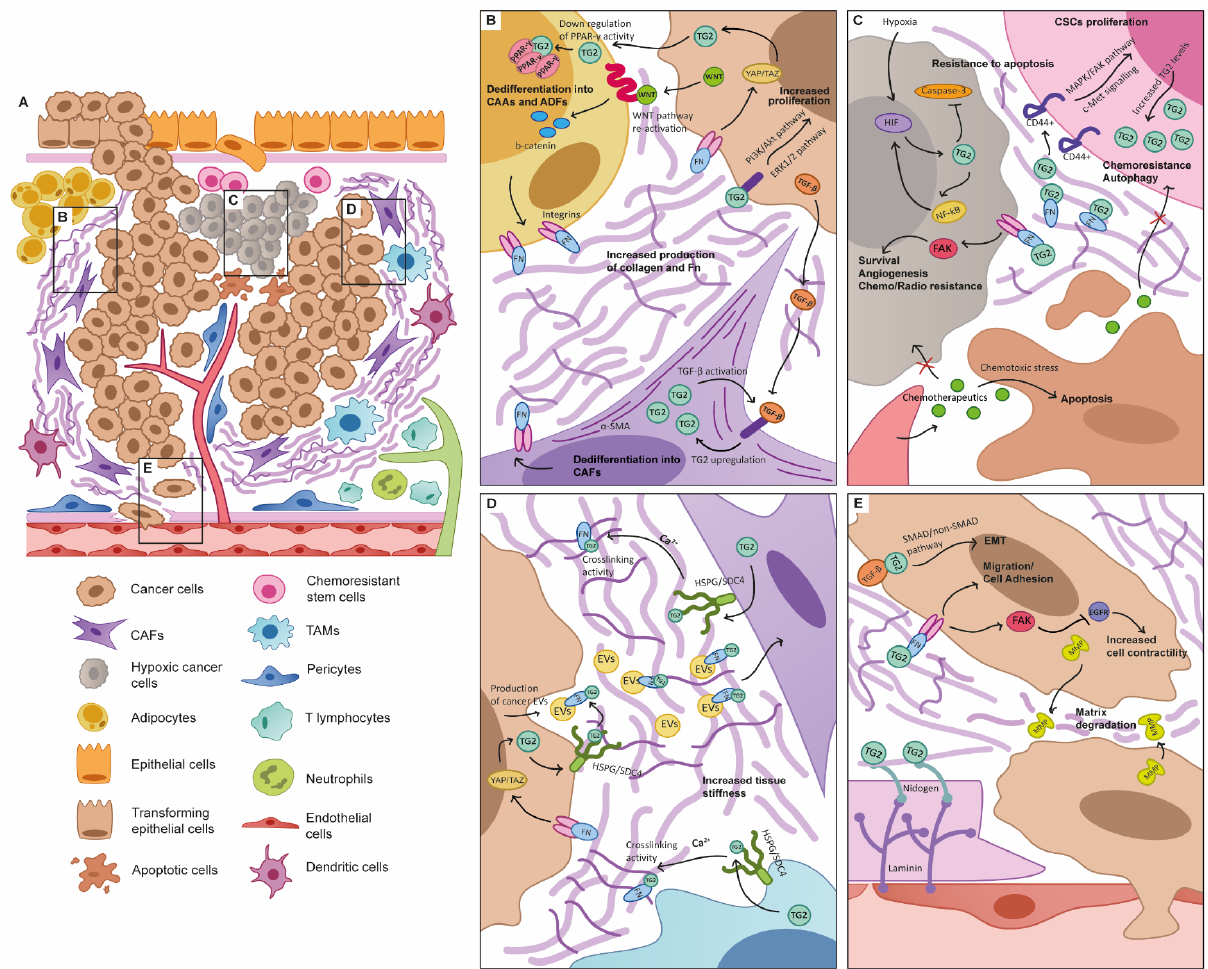
Figure 1. TG2 roles in the tumour microenvironment (TME). ( A ) Schematic representation of the tumour microenvironment (TME) showing the presence of resident and infiltrated cellular constituents and extracellular matrix (ECM) components. Cancer, stroma, and immune system constantly interact, and within this complex system TG2 plays a role in multiple pathways and responses. Subfigures B-E are magnifications of the indicated areas within the TME. ( B ) TG2 is linked to adipocyte and fibroblast phenotype. Upregulation of cancer-derived TG2 may inhibit adipogenesis by cross-linking of proliferative-activated receptor y (PPAR γ ) along with other events, such as the re-activation of WNT canonical pathway. The TGF- β /TG2 link is associated with the activation of fibroblasts to a de-differentiated, contractile cancer-associated fibroblast (CAF) phenotype. Increased stromal stiffening enhances integrin activation and signalling through pathways such as YAP/TAZ which can further regulate TG2 expression. ( C ) TG2 in chemoresistance, apoptosis, and replicative immortality. Chemotherapeutics induce apoptosis in sensitive cancer cells, but in chemoresistant cells several mechanisms are activated to contrast death. A hypoxic-induced loop between HIF/TG2/NF- κ B is responsible for apoptotic resistance in cancer cells. Increased expression of TG2 promotes chemoresistance and survival in cancer cells through several pathways but also through the binding with integrins and the activation of FAK signalling. TG2 increases CD44+ activation, leading to the high proliferative and chemo-resistant cancer stem cell (CSC) phenotype. ( D ) TG2 cross-linking activity contributes to TME stiffening of the primary and metastatic sites. TG2 linked to fibronectin (FN) upon HSPG/SDC4 release from fibroblasts and macrophages in the extracellular space activates its cross-linking activity, remodelling the ECM and contributing to cancer cells migration and fibrosis. Cancer-derived extracellular vesicles (EVs) express TG2/FN on their membranes and alter the metastatic niche through paracrine signalling. ( E ) TG2 is linked to cancer invasive behaviour. The reciprocal relationship between TGF- β and TG2 mediates epithelial-to-mesenchymal transition (EMT) in cancer cells, leading to enhanced migration, which is also increased by the binding TG2/Fn/integrins and the following adhesion to the ECM. Increased cell contractility is promoted by downstream signalling of TG2/Fn/integrins binding, such as the inhibition of EGFR activity through FAK signalling. The balance between TG2 enzymatic activity on laminin/nidogen complexes and upregulation of matrix metalloproteinases (MMPs) by cancer cells contributes to basement membrane (BM) integrity, and thus invasive